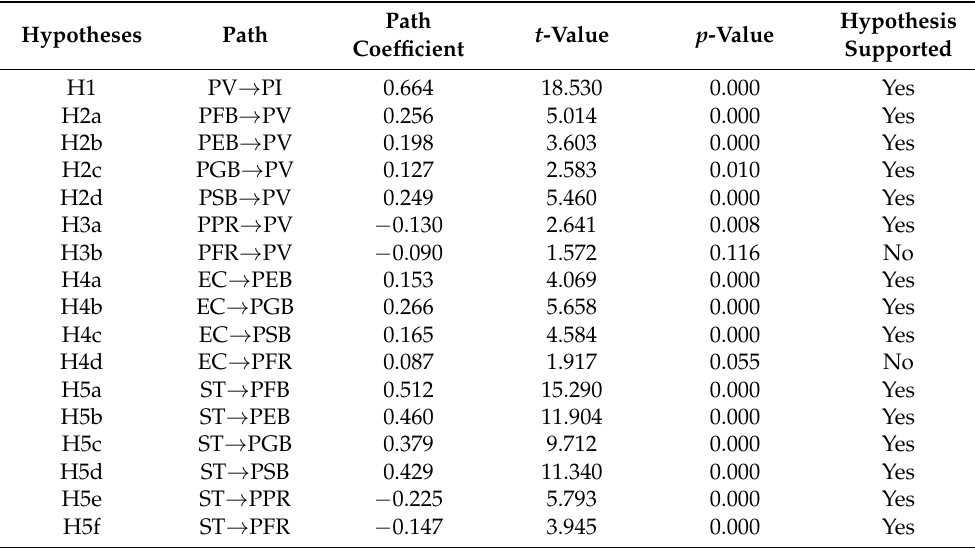
Table 5. Path analysis and significance verification of the structural models.